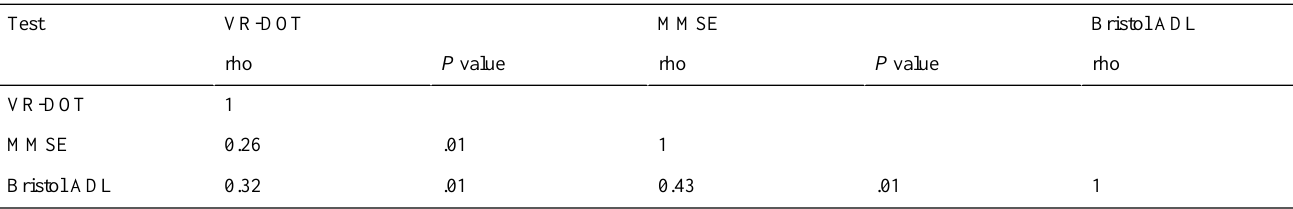
Table 2. The correlation matrix between Virtual Reality Day-Out Task (VR-DOT) functional index, mini-mental state examination (MMSE), and Bristol Activities of Daily Living (ADL) when controlling for age, gender, and education status.